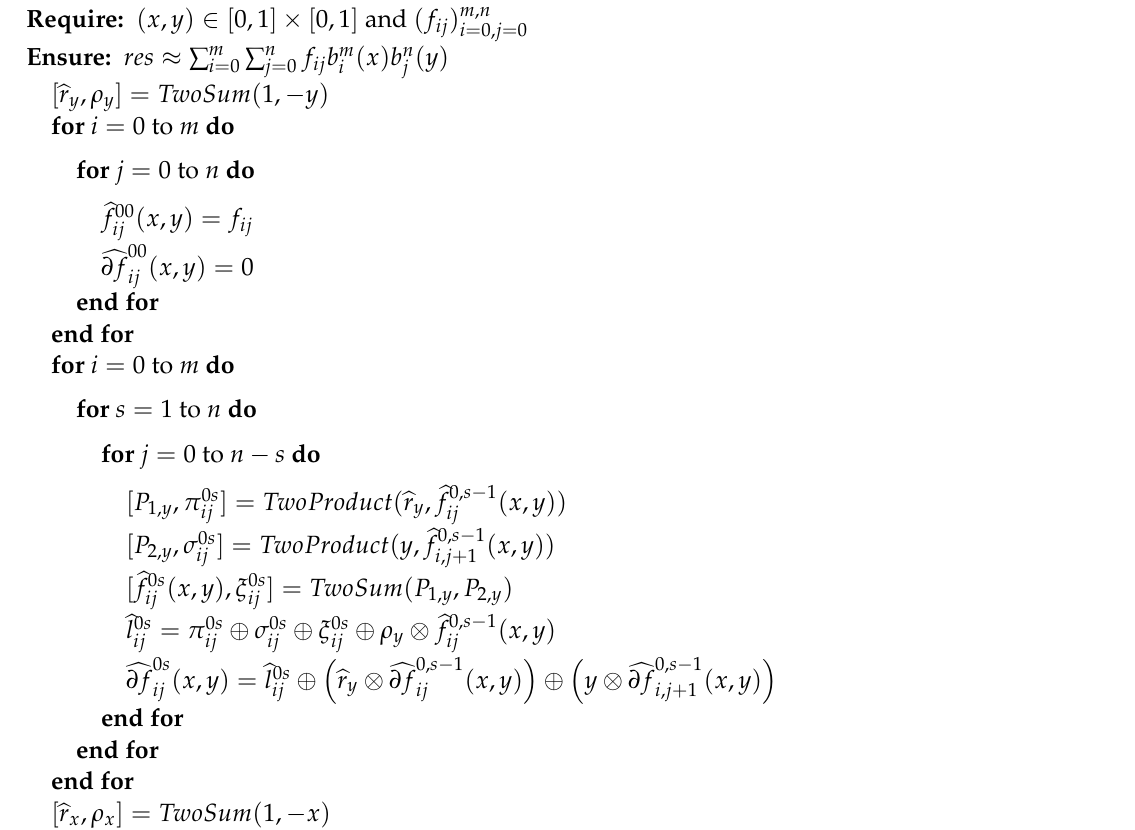
Algorithm 6 Compensated de Casteljau algorithm for the evaluation of F in